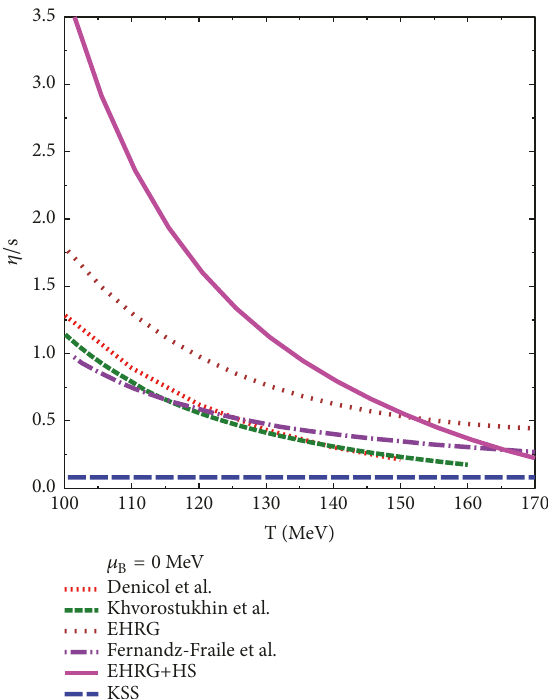
Figure 4: Comparison of the ratio 𝜂/𝑠 estimated within our model, i.e., MEHRG (solid magenta curve), with various other methods. The red dashed curve corresponds to the Chapman-Enskog method [43] with constant cross sections. The dashed green curve corresponds to estimations made within the SHMC model of the hadronic matter [44]. The brown dashed curve corresponds to estimations made within the EHRG model [45]. The dot-dashed orchid curve corresponds to 𝜂/𝑠 of meson gas estimated using the chiral perturbation theory [46].